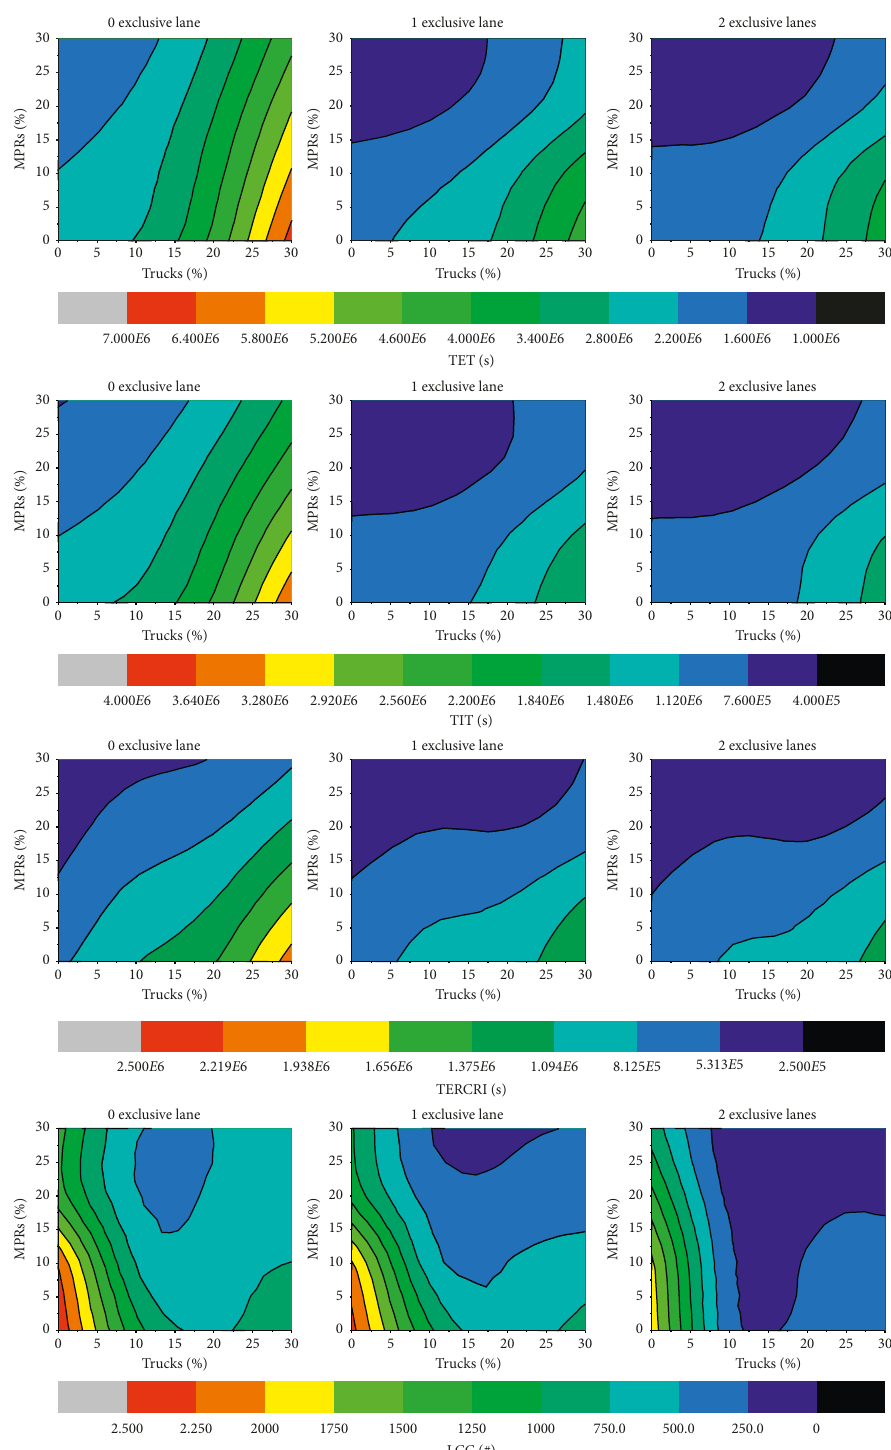
Figure 7: Safety evaluation results of CAV’s exclusive lane on volume �